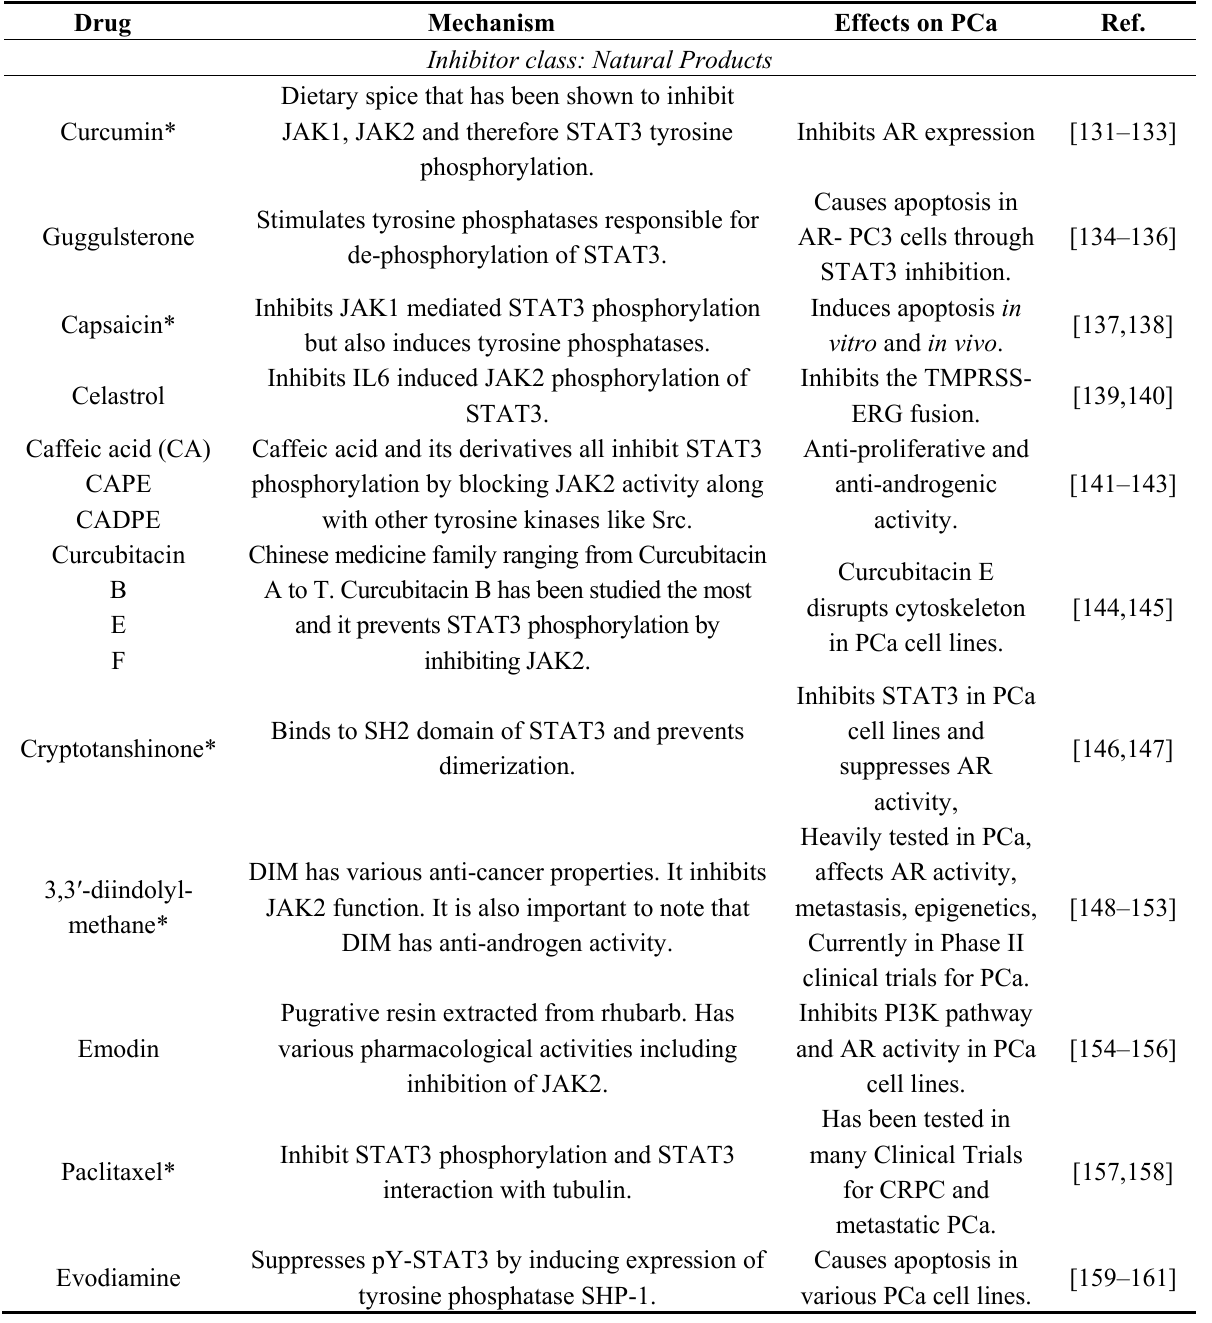
Table 1. List of different drugs targeting STAT3 signaling pathway in